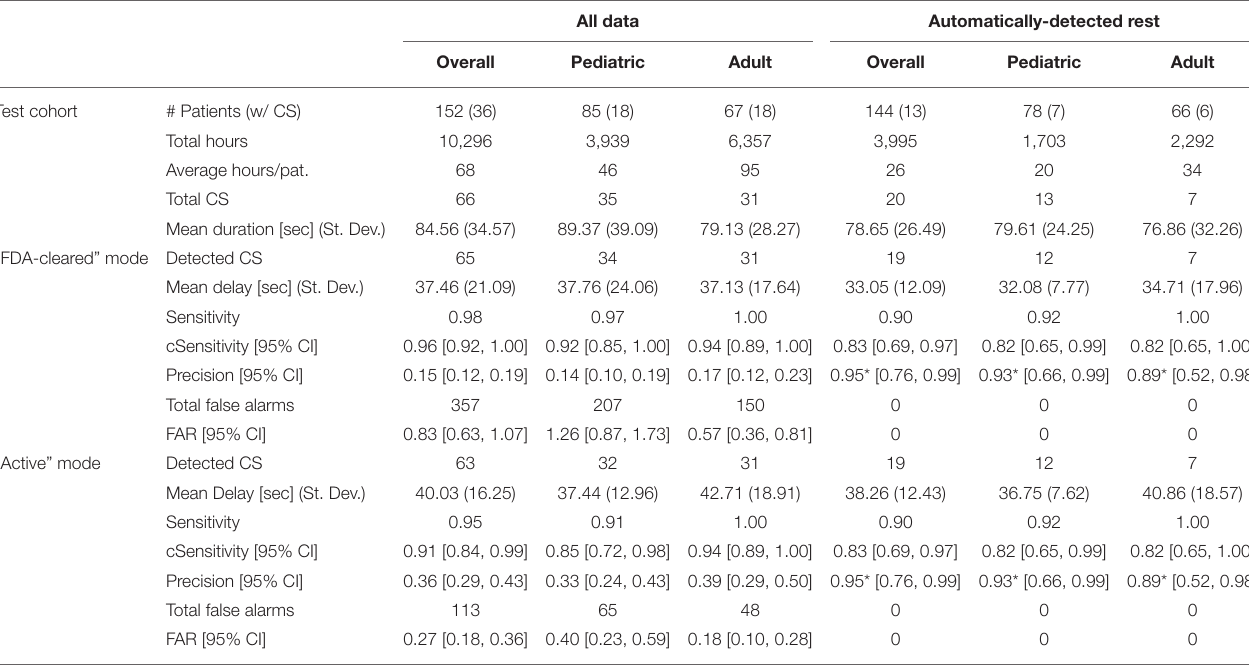
TABLE 3 | Characteristics of the Test Cohort and performance of the Detection Algorithm for all the patients and the two age groups, for the two different operating points of the algorithm (“FDA-cleared” mode and “Active” mode, and for all the data (“All data”) vs. only periods of rest (“Automatically-Detected Rest”).